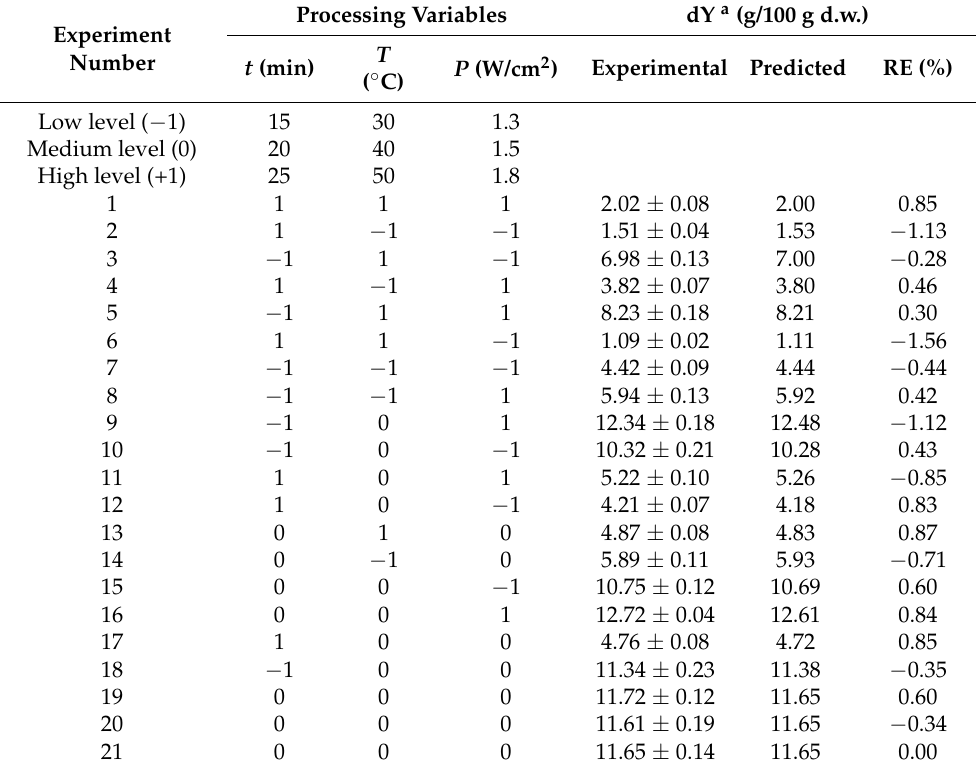
Table 1. Experimental design and experimental